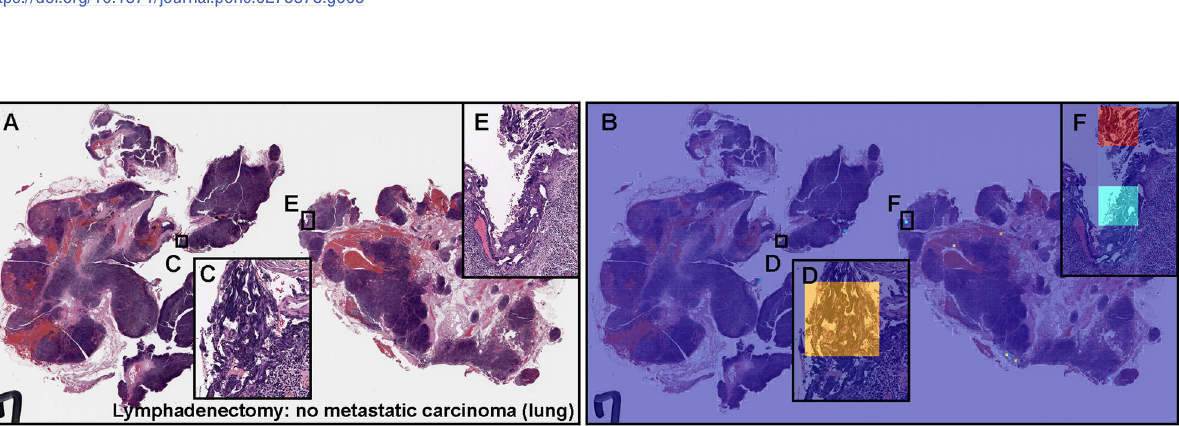
PLOS ONE | https://doi.org/10.1371/journal.pone.0275378 November23,